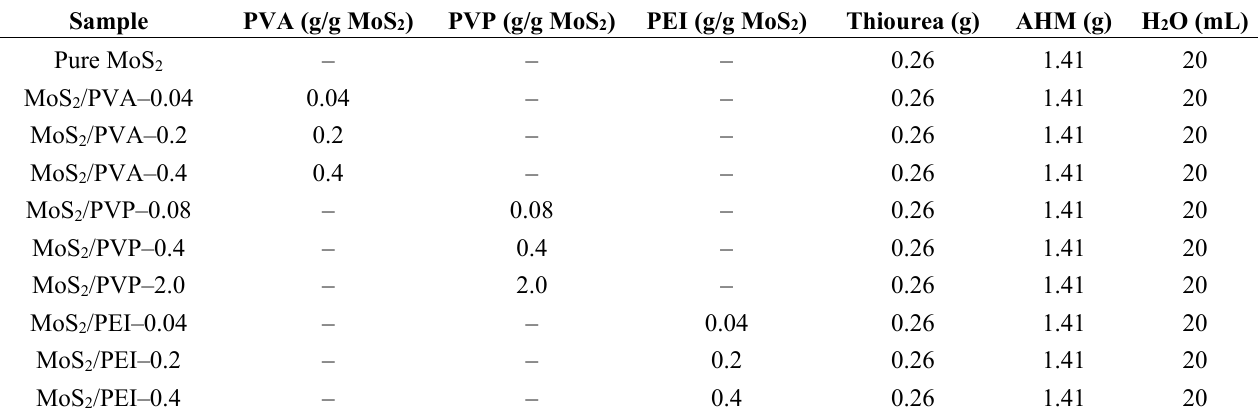
Table 1. Additions of reagents for MoS 2 /polymers catalysts with the hydrothermal synthesis process. Polyvinyl alcohol (PVA), polyvinylpyrrolidone (PVP), polyethylenimine (PEI), Thiourea, ammonium molybdate tetrahydrate (AHM) and H 2 O are listed. Sample PVA (g/g MoS 2 ) PVP (g/g MoS 2 ) Pure MoS 2 MoS 2 /PVA–0.04 MoS 2 /PVA–0.2 MoS 2 /PVA–0.4 MoS 2 /PVP–0.08 MoS 2 /PVP–0.4 MoS 2 /PVP–2.0 MoS 2 /PEI–0.04 MoS 2 /PEI–0.2 MoS 2